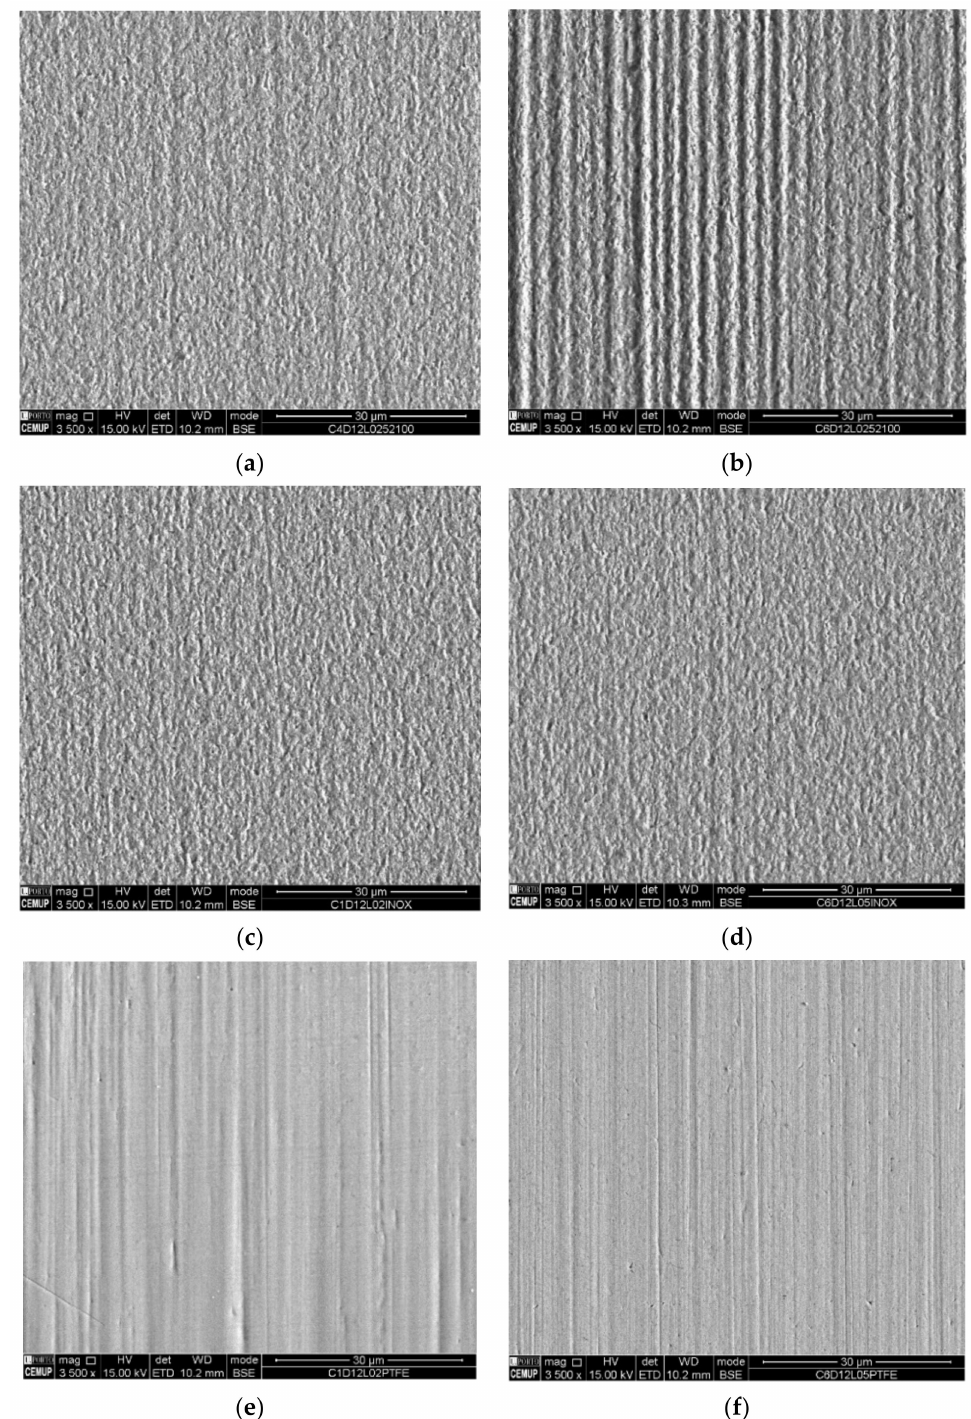
Figure 16. Evolution of the groove marks visible on the craters by SEM for the diamond (1–2 µ m) abrasive: ( a ) AISI 52100; load 0.2 N, ( b ) AISI 52100; load 0.5 N, ( c ) SS AISI 304; load 0.2 N, ( d ) SS AISI 304; load 0.5 N, ( e ) PTFE; load 0.2 N, ( f ) PTFE; load 0.5